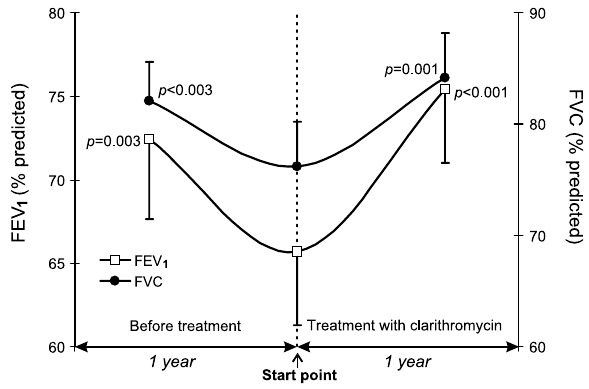
FIG. 1. Pulmonary function test results. The data are presented as mean values of forced vital capacity (FVC) and forced expiratory volume in 1 sec (FEV 1 ). The results were analyzed using a paired